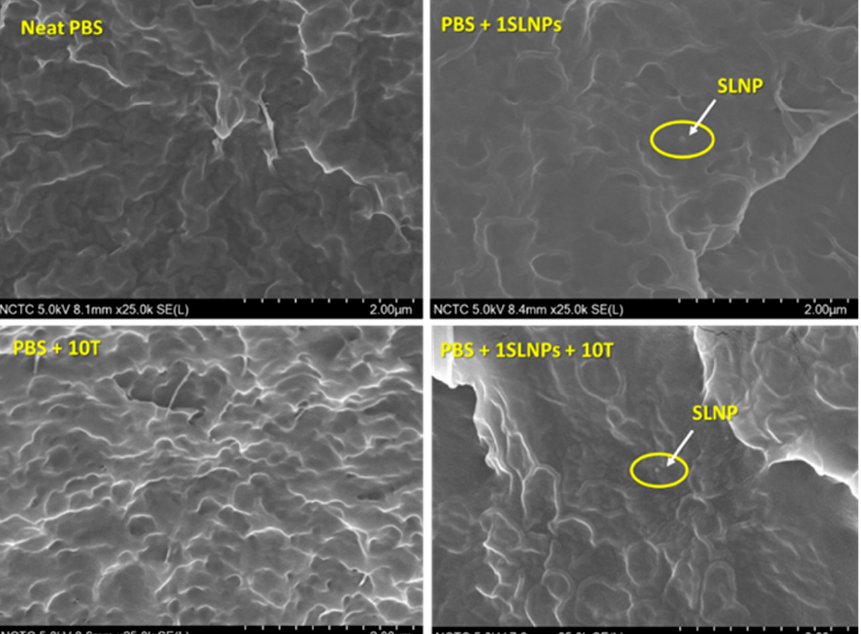
Figure 1. SEM images of cryo-fractured cross-section (side view) of neat polybutylene succinate (PBS) and PBS composite films with thymol (T) at a magnification of ×25 K. The size of softwood kraft lignin nanoparticles (SLNPs) ranged from 40–300 nm with an average particle size of 120 ± 18 nm and average polydispersity index (PDI) of 0.07 ± 0.01, determined by dynamic light scattering (DLS) technique at 25 °C (Malvern Zetasizer-4 Instrument, Malvern, UK).